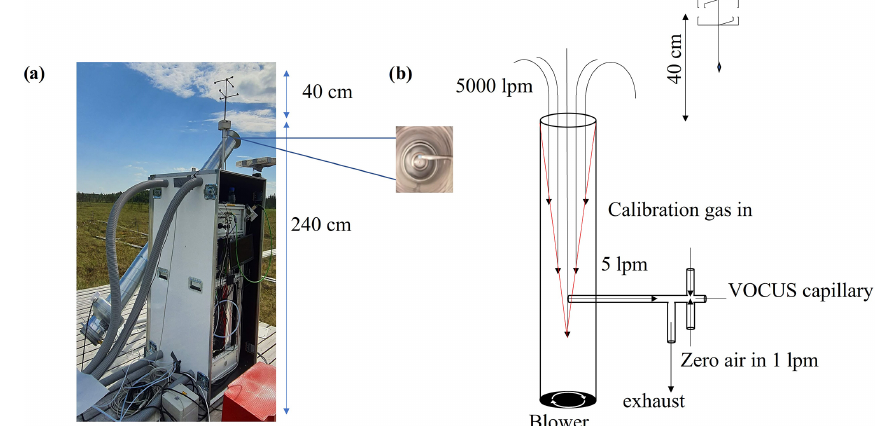
Figure 1. (a) Eddy covariance flux measurement setup with a high-flow inlet, with the core sampling inlet visible when looking straight into the main inlet (inset), and (b) schematic of the flows involved in sampling, calibrating, and zeroing.